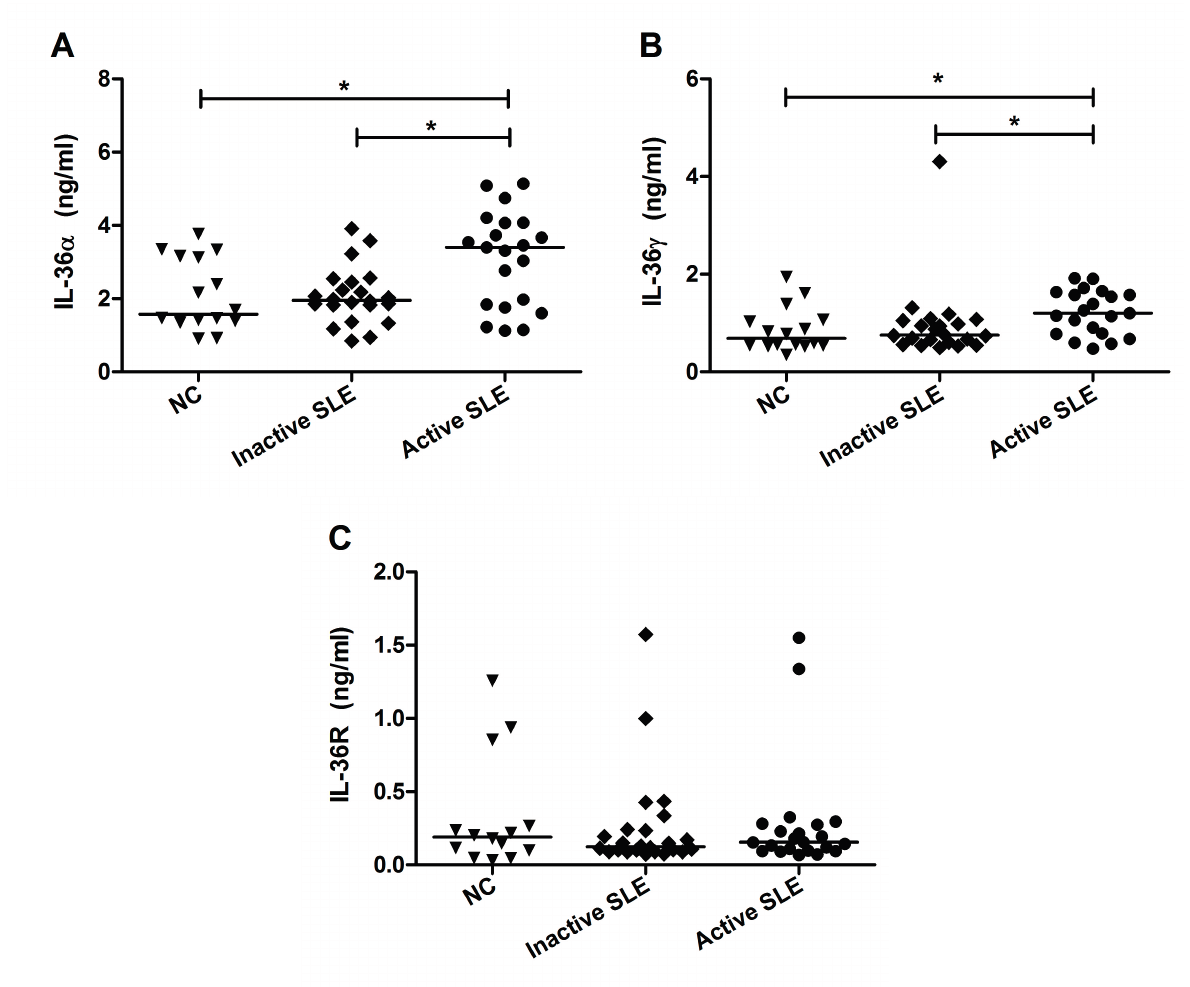
Figure 1. Comparison of plasma IL-36 concentrations between SLE patients and NC. Plasma concentrations of ( A ) IL-36 α ; ( B ) IL-36 γ and ( C ) IL-36R from inactive ( n = 22) and active ( n = 21) SLE patients and NC ( n = 16) were measured using ELISA. Results are presented as scatter plots with median. Statistical significances were indicated by * p < 0.05 (Mann-Whitney U